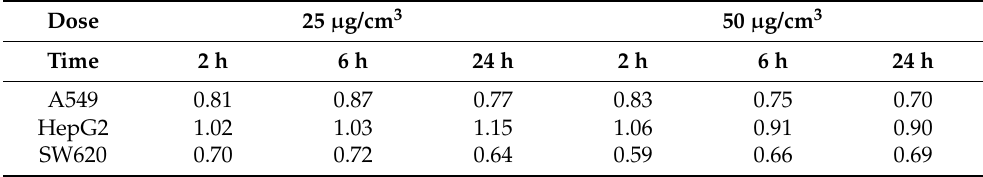
Table 2. Densitometry quantification of ABCB1 protein expression. Data normalized to untreated cells.